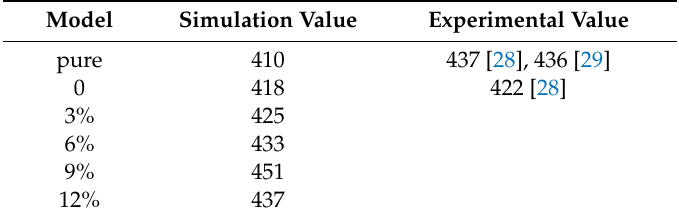
Table 1. Glass transition temperature of di ff erent grafting models (K).